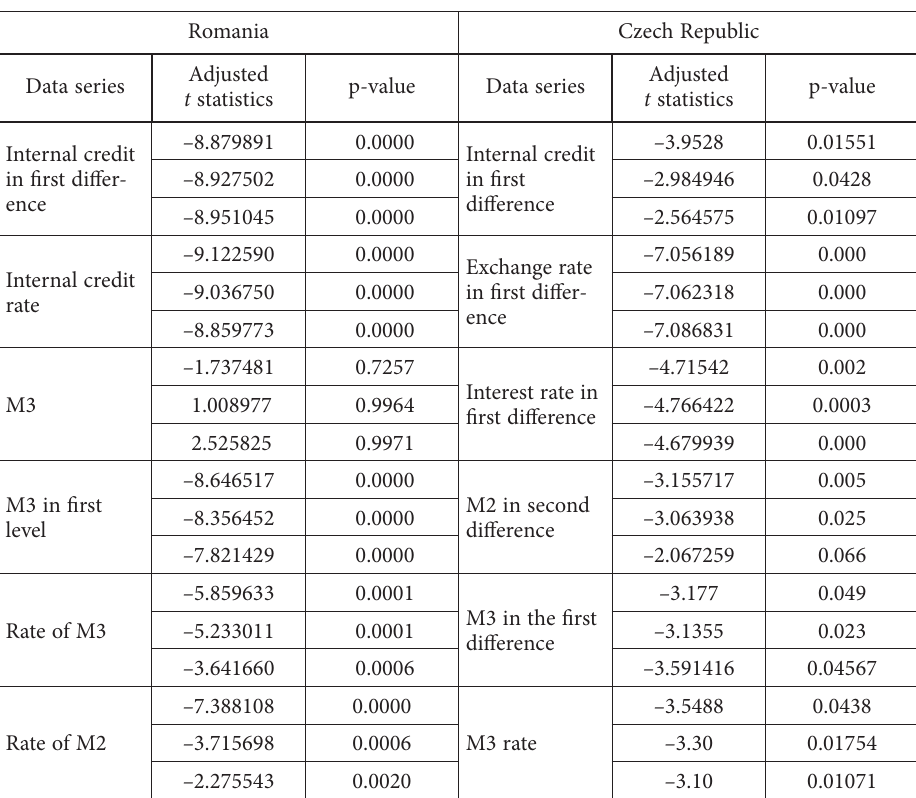
Table 4. Granger causality between economic growth and rate of M3 , respectively rate of internal credit in Romania (source: authors’ calculations) Hypothesis F computed p-value Rate of internal credit does not cause economic growth in Grang- 0.25518 0.7754 er approach